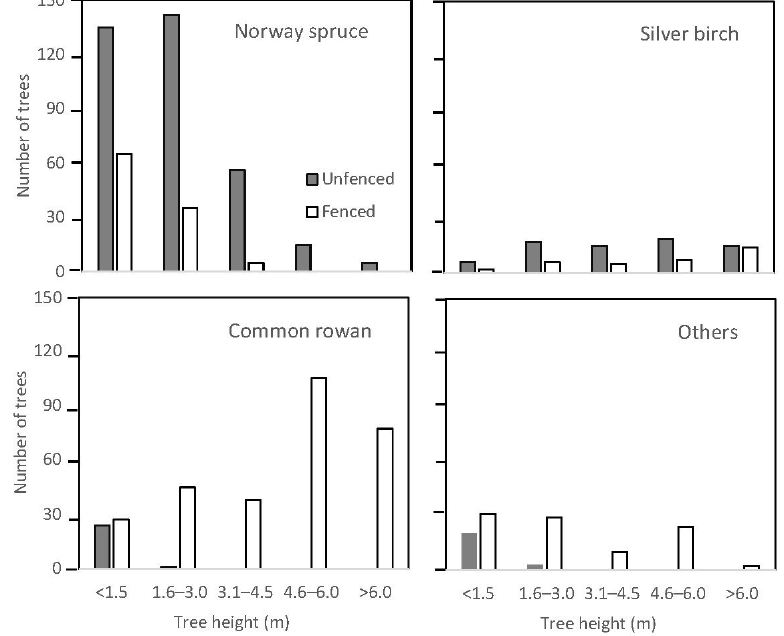
Figure 4. Comparison of tree distribution in Norway spruce, silver birch, common rowan, and other